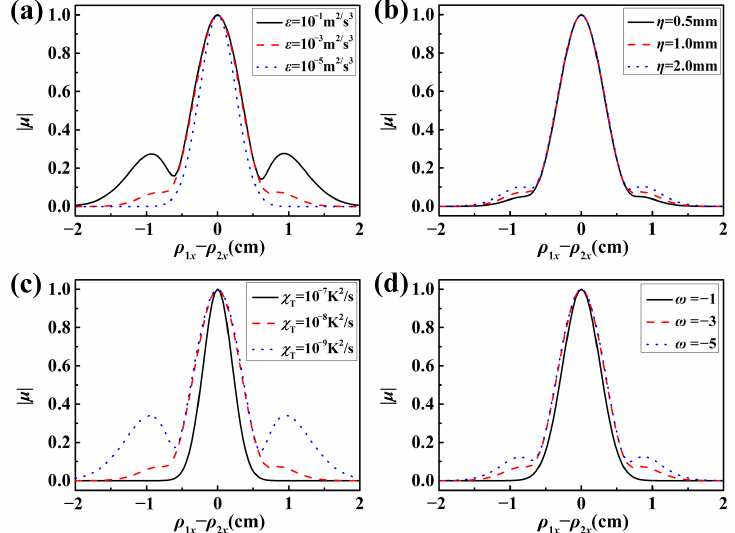
Figure 3. Cross line ( ρ 1 y − ρ 2 y = 0) of the SDOC modulus at a propagation distance of z = 300 m for various oceanic turbulence parameters: ( a ) the kinetic energy dissipation rate per unit mass of the fluid; ( b ) the Kolmogorov inner scale; ( c ) the dissipation rate of the mean-square temperature; ( d ) the relative strength of the temperature to salinity undulations.